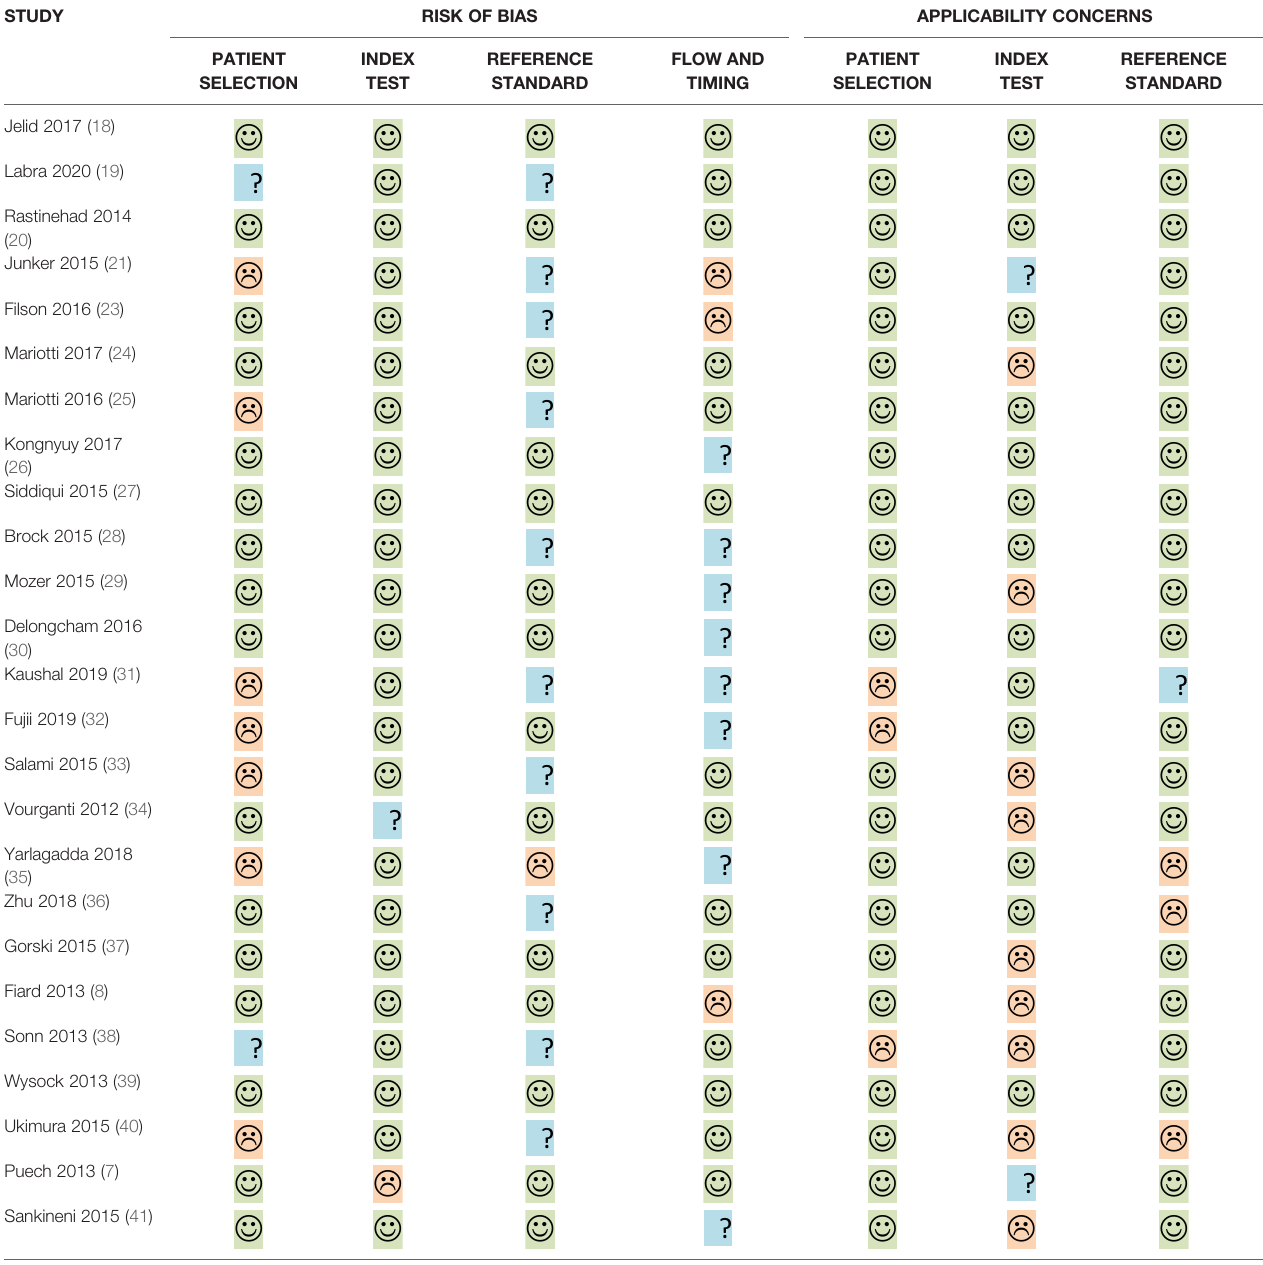
TABLE 2 | Quality assessment according to QUADAS-2 of the included